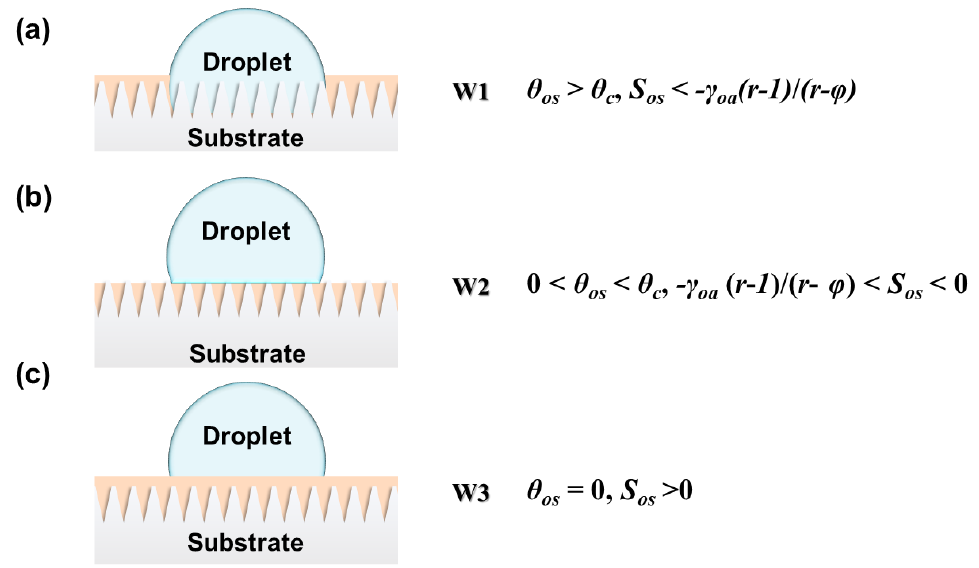
Figure 2. Scheme of ( a ) a droplet replacing the lubricant inside the roughness wet by the substrate; ( b ) wets the solid with a nonzero contact angle; ( c ) the droplet fails to replace the lubricant.